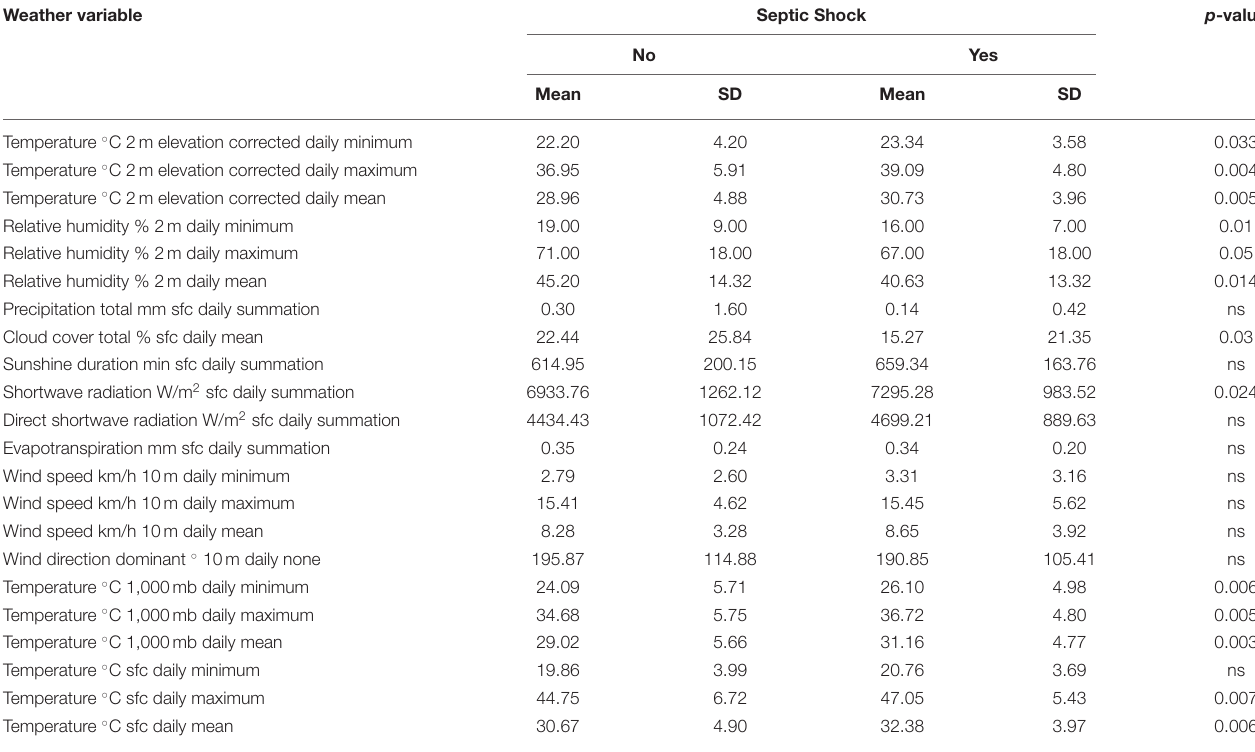
TABLE 3F | Difference in day-of-admission weather variables in Dubai City between COVID-19 patients’ clinical outcomes: Septic shock. Weather